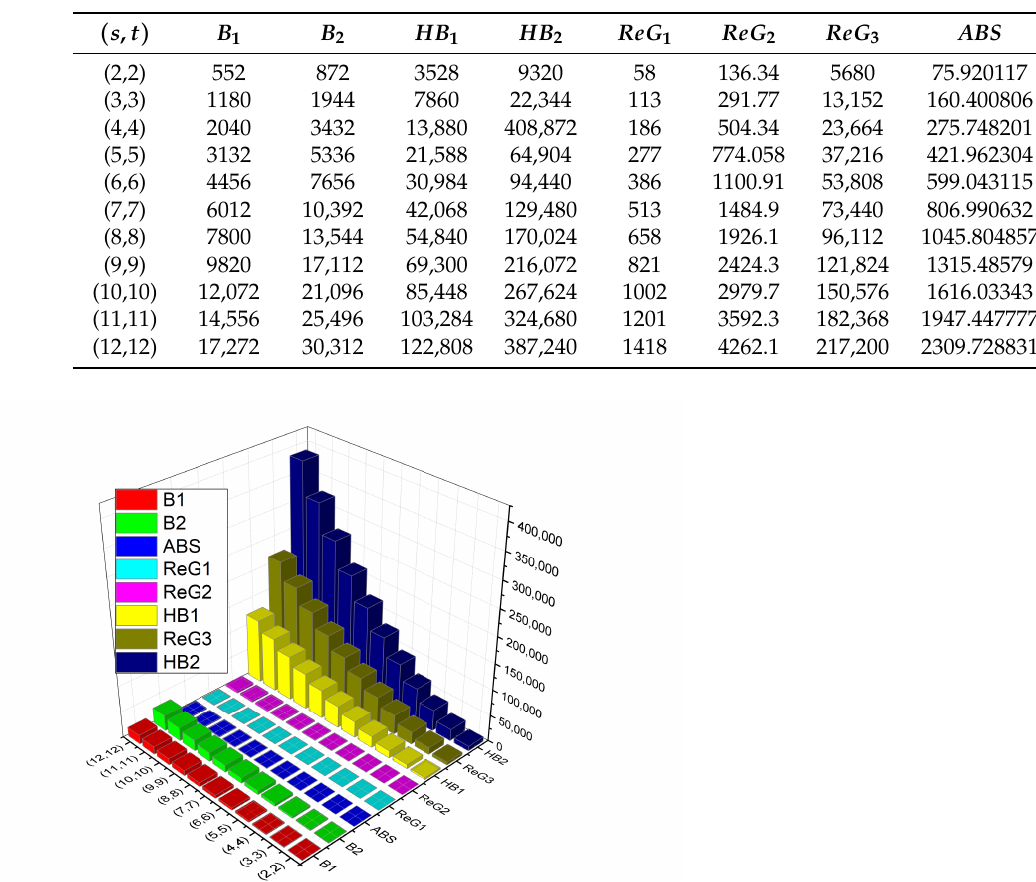
Table 2. Numerical comparison of the K -Banhatti topological indices of NbO 2 .